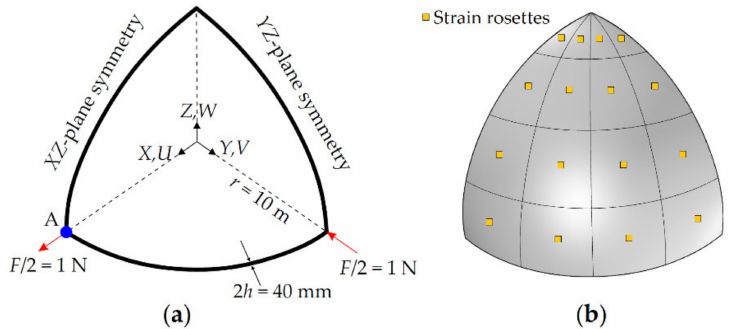
Figure 10. ( a ) Pinched hemisphere with symmetric boundary conditions; ( b ) its discretization (n e = 4), using iKLS elements with top- and bottom-surface strain rosettes per each element [41].